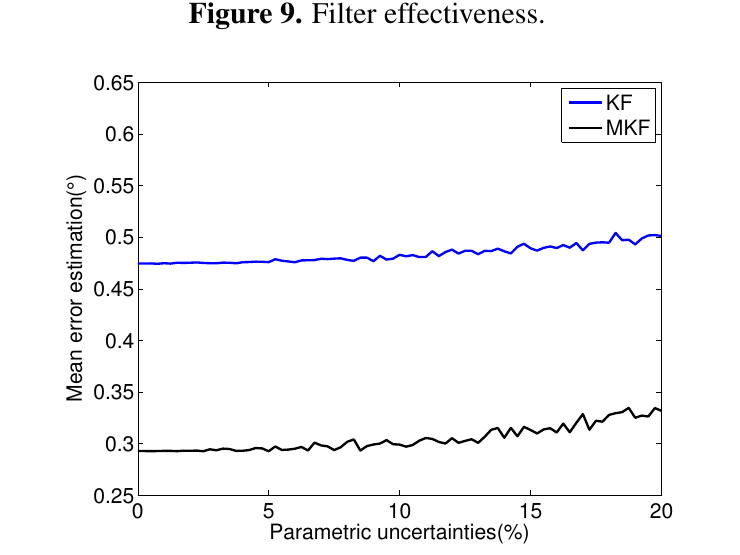
Figure 9. Filter